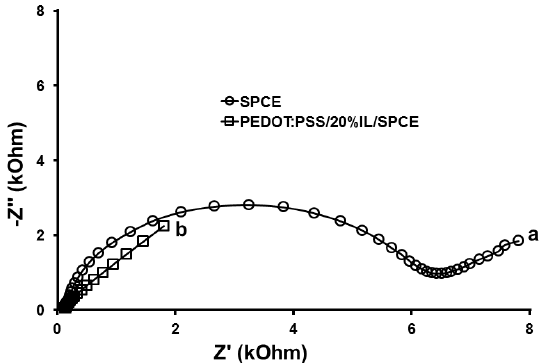
Figure 3. Nyquist plots observed for electrochemical impedance spectroscopy (EIS) at SPCE (curve a) and PEDOT:PSS/20%IL/SPCE sensor (curve b) in PBS (pH 7.4) containing 5.0 mM [Fe(CN) 6 ] 3 − /[Fe(CN) 6 ] 4 − and 0.1 M KCl.